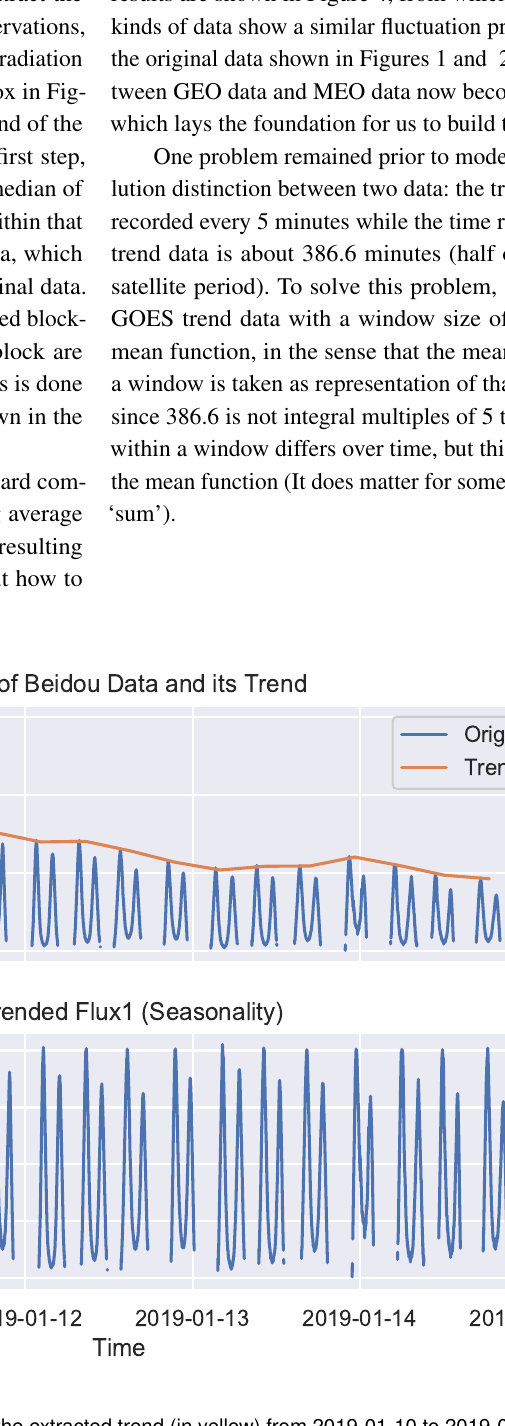
Figure 3. Top panel: Flux1 of Beidou data (in blue) and the extracted trend (in yellow) from 2019-01-10 to 2019-01-14 with the red rectangle box representing a ‘block’; Bottom panel: detrended Flux1, also called seasonality, obtained by using the trend to divide original